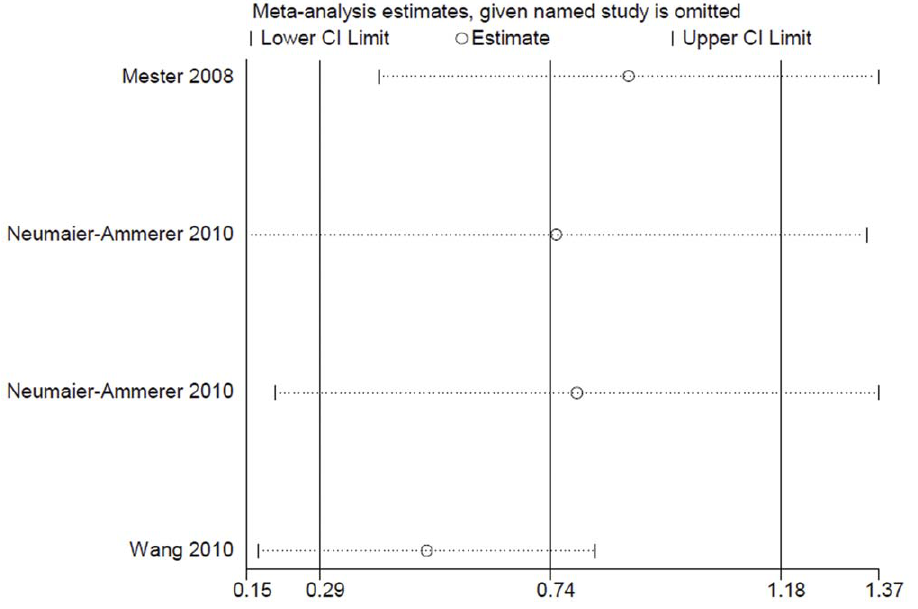
Figure 9. Sensitivity analysis of postoperative color vision in the blue light spectrum under mesopic light condition.